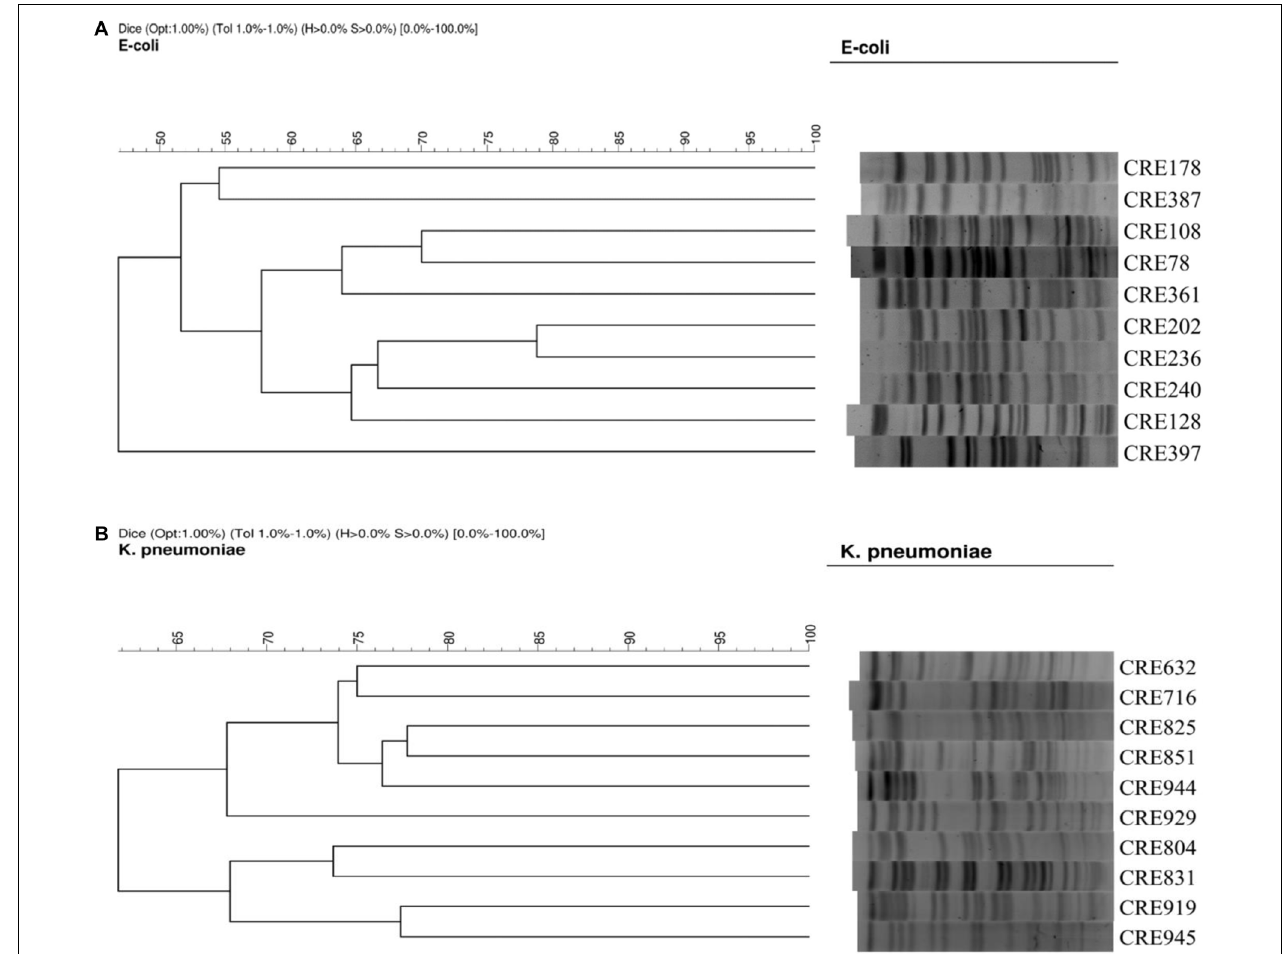
FIGURE 1 | (A) PFGE of 10 isolates of carbapenem-resistant E. coli. (B) PFGE of 10 isolates of carbapenem-resistant K. pneumoniae.